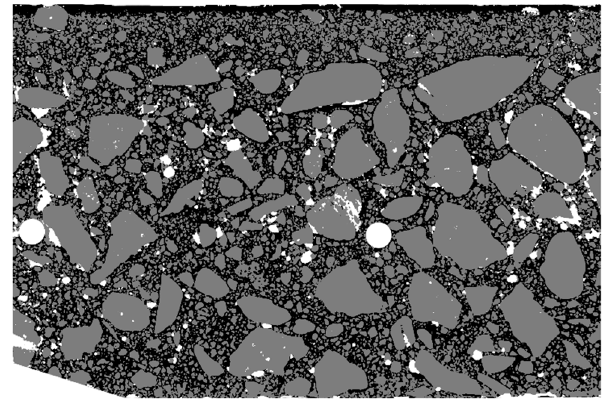
Figure 21. Arrangement of pores (white), aggregate (gray), and cement matrix (black) in the section of the element wall.